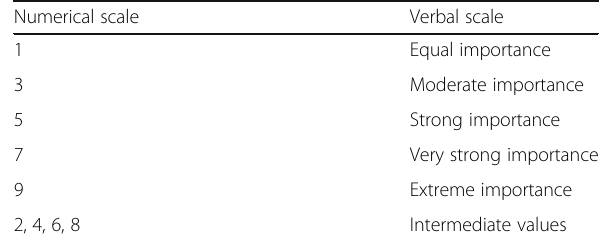
Table 1 Saaty ’ s fundamental scale (value of a jk ) [40] Numerical